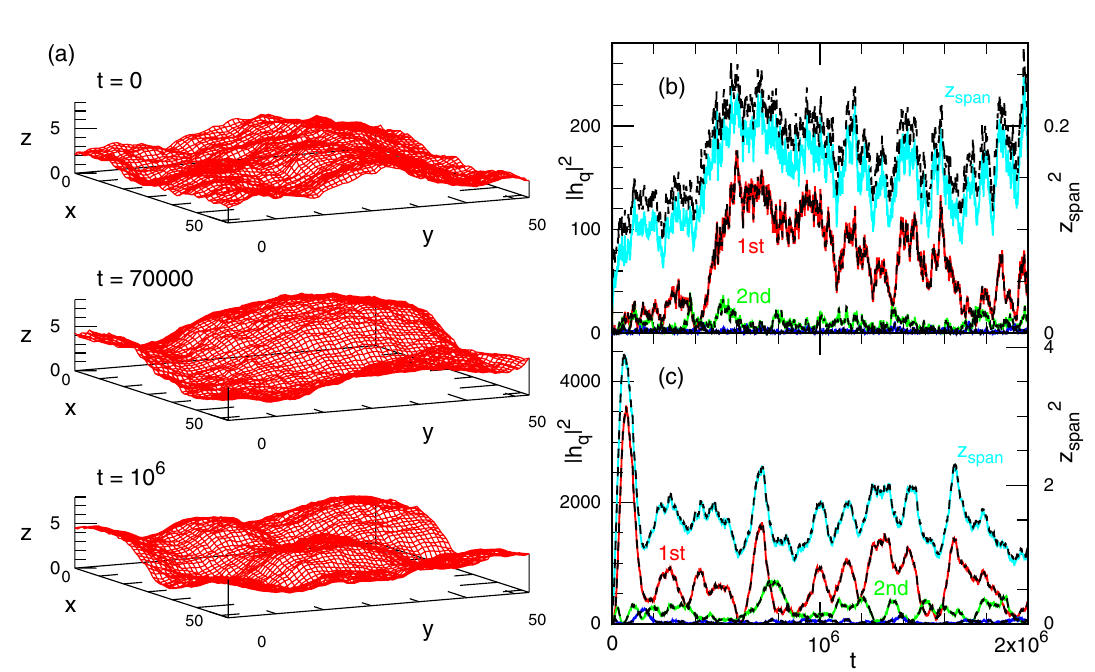
z 2 Figure 6. Vertical span span (cid:30) of the membrane and filament surfaces. ( a , b ) Dependence on (cid:31) and 10 in ( a ) case I and ( b ) case II. The solid and dashed lines represent the data for the membrane and filaments, respectively. ( c , d ) Dependence on system size N for ( c ) γ magenta lines in ( c ) and ( d ) represent the data at thermal equilibrium. The dashed black line in ( c ) indicates 3 κ , which overlays the thick magenta line. (cid:31) z span 2 (cid:30) = N / 8 π